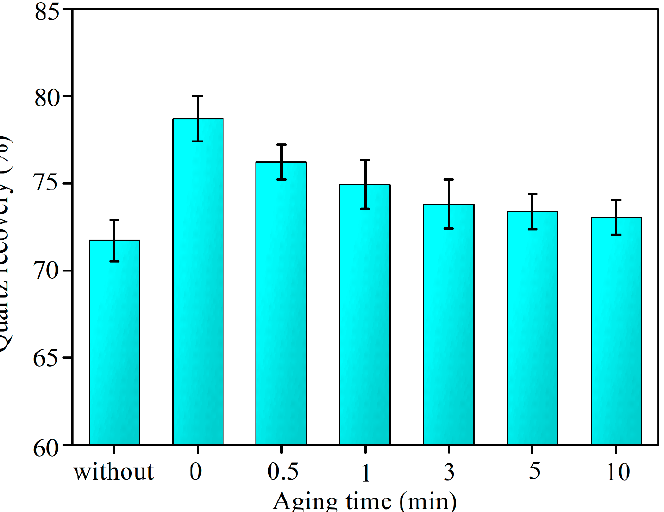
Figure 10. Flotation recovery of quartz varies with the ageing time of aqueous dispersion containing BMNBs at preparation time of 2 min and aeration rate of 0.5 L/min. BMNBs at preparation time of 2 min and aeration rate of 0.5